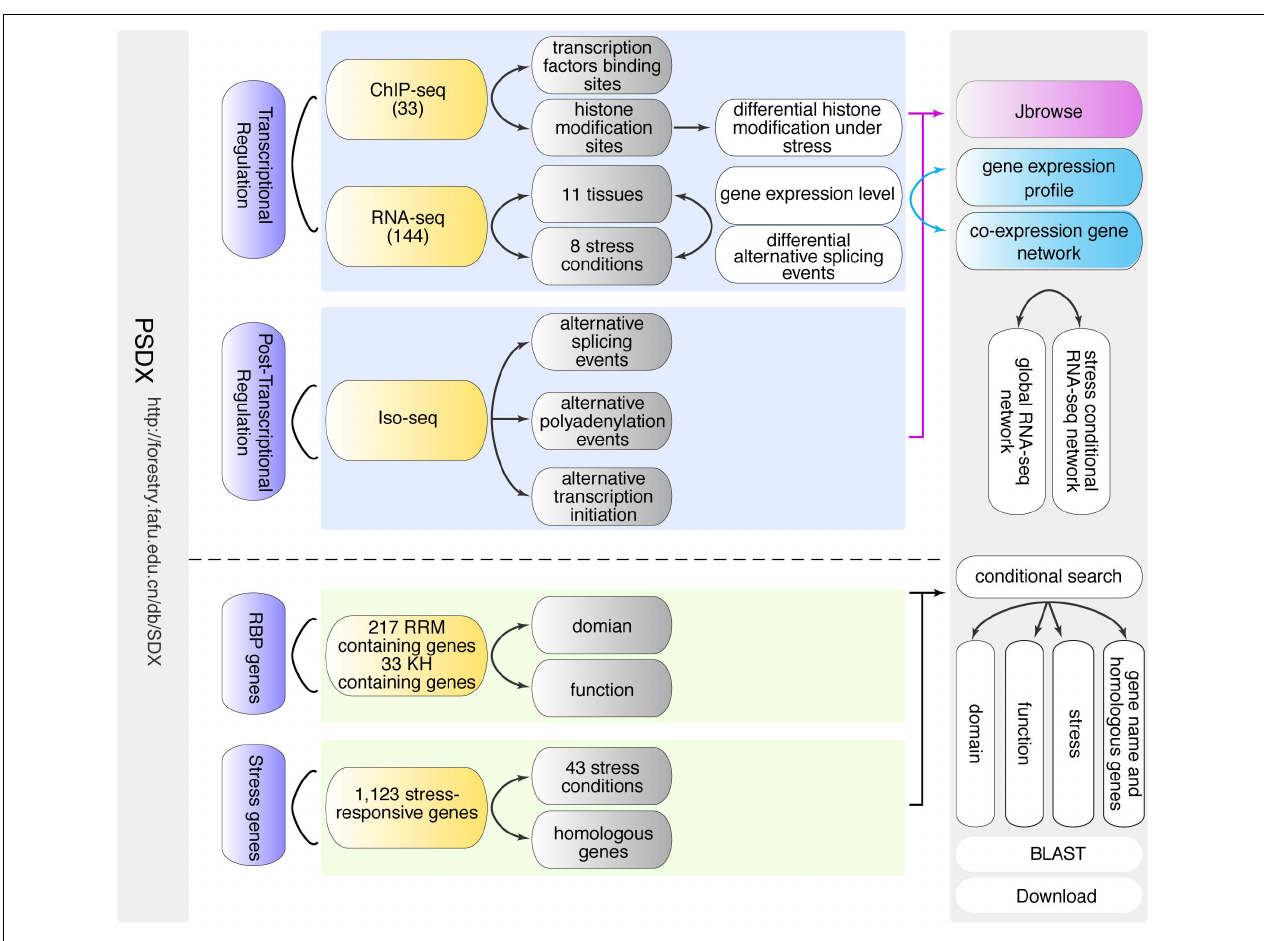
FIGURE 1 | Schematic overview of PSDX database. PSDX consists of two major resources including transcriptional regulation and post-transcriptional regulation under different stress conditions and in different tissues in P. trichocarpa . PSDX also includes several other modules: co-expression network, RBP genes, stress-responsive genes, and conditional